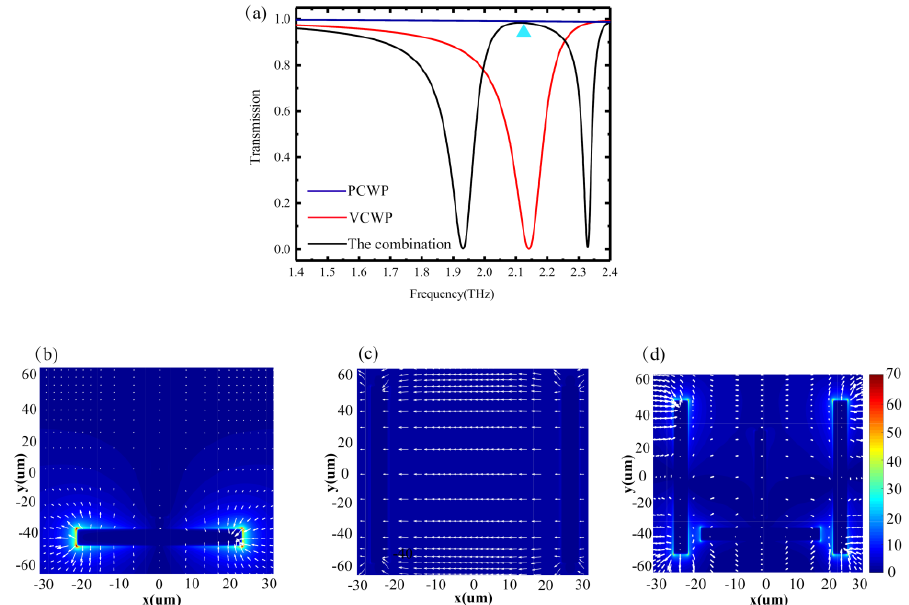
Figure 3. ( a ) Transmission spectra of the parallel cut wire pair (PCWP) alone, the vertical cut wire pair (VCWP) alone, and the EIT metamaterial. Distribution of the local electric field of (the blue arrow points to 2.14 THz) ( b ) the VCWP, ( c ) the PCWP, and ( d ) the combined EIT structure at a frequency of 2.14 THz.